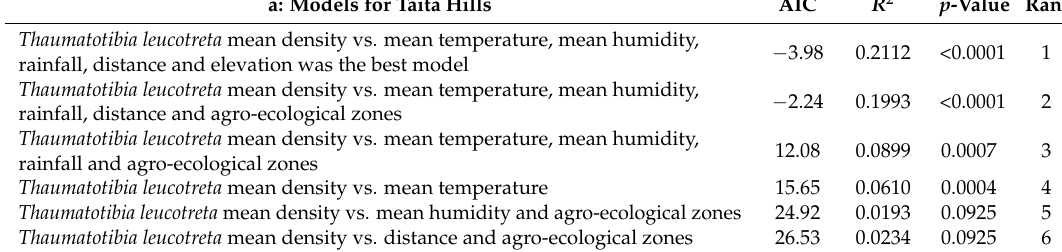
b: Models for Mount